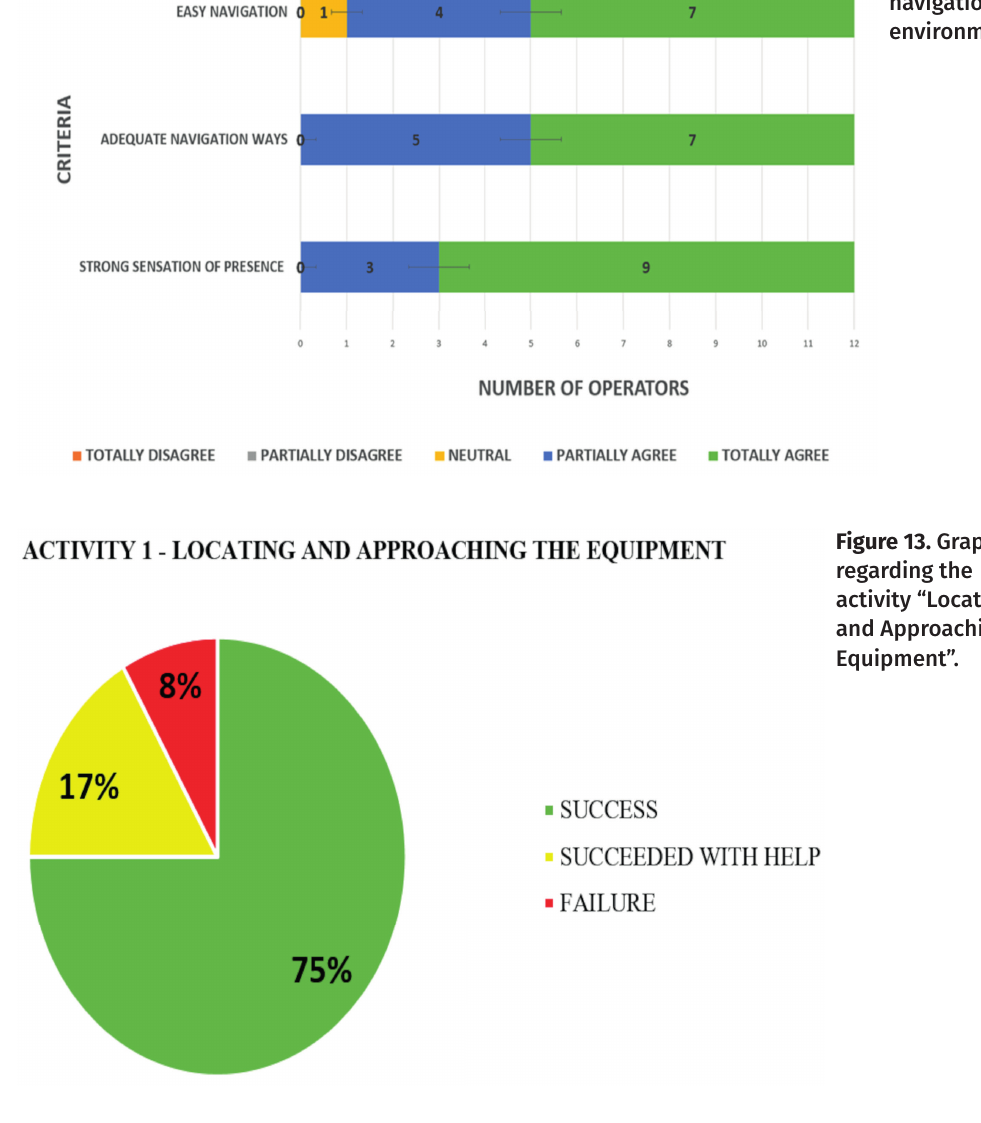
Figure 12. Graph regarding the analysis criteria about the navigation in the 3D